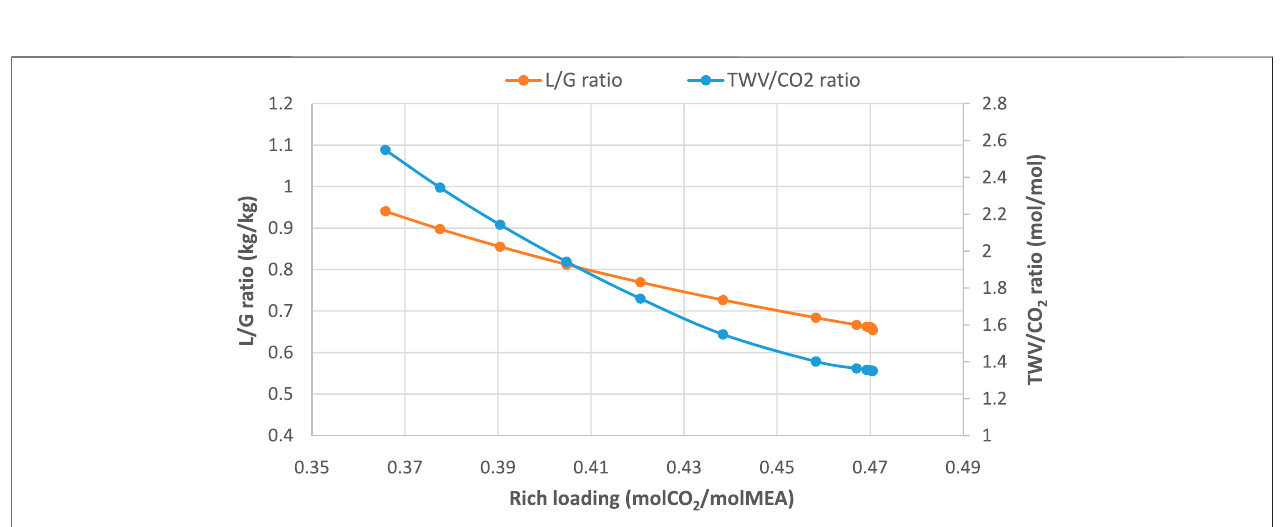
FIGURE 5 | L/G ratio and TWV/CO 2 ratio as a function of rich loading. Lean loading is 0.12 molCO 2 /molMEA and stripper pressure is 2.4 bar.